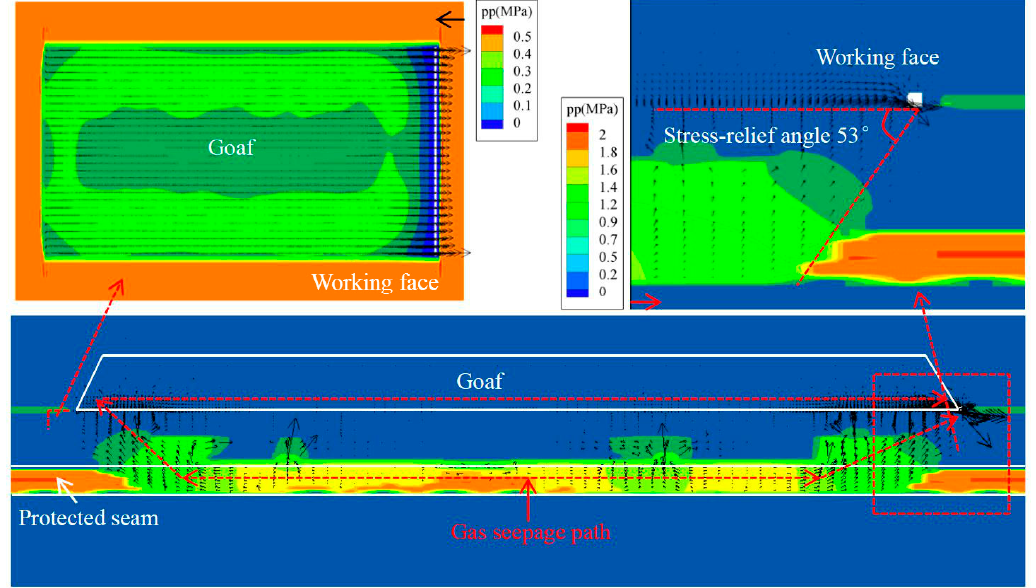
Figure 10. Gas seepage path during the mining process.